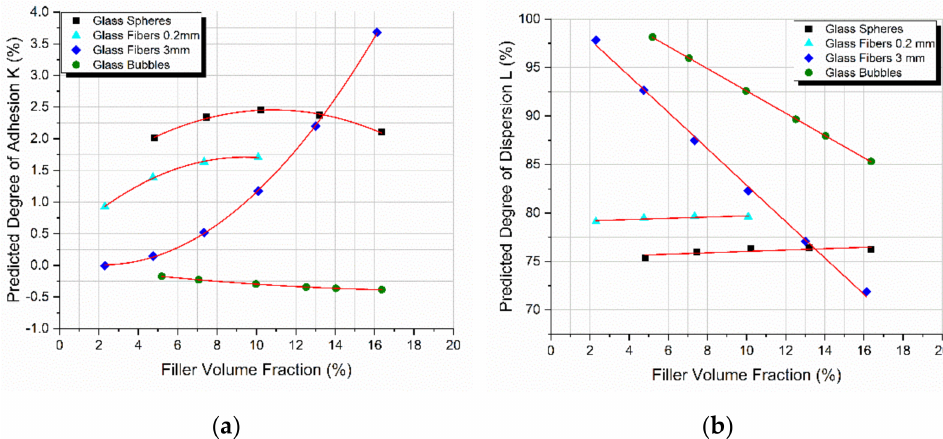
Figure 7. Predicted degree of ( a ) adhesion and ( b ) dispersion as a function of the filler-volume fraction for all types of composites studied.